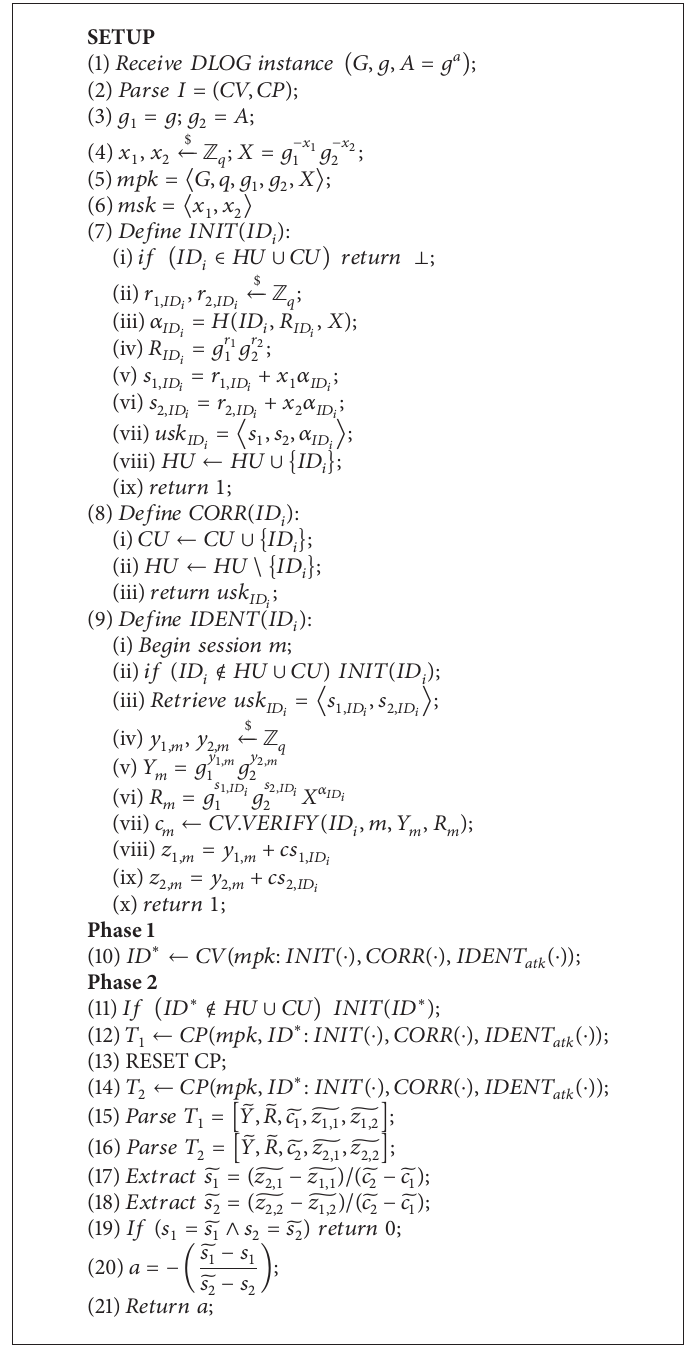
Algorithm 4: Description of the Simulator 𝑀 solving an instance of the discrete logarithm problem with the help of impersonator 𝐼 as